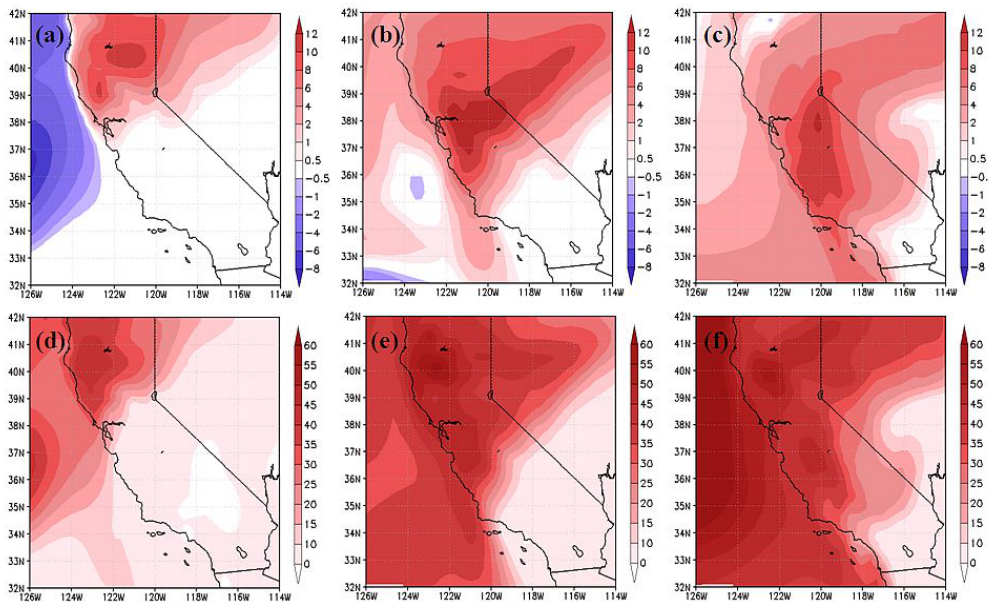
Fig. 15. Surface O 3 (a–c) and CO (d–f) difference (Base case – Obs case) over California from 60km model simulations at 18:00UTC on 22 June (a; d), 23 (b; e) and 24 (c; f).